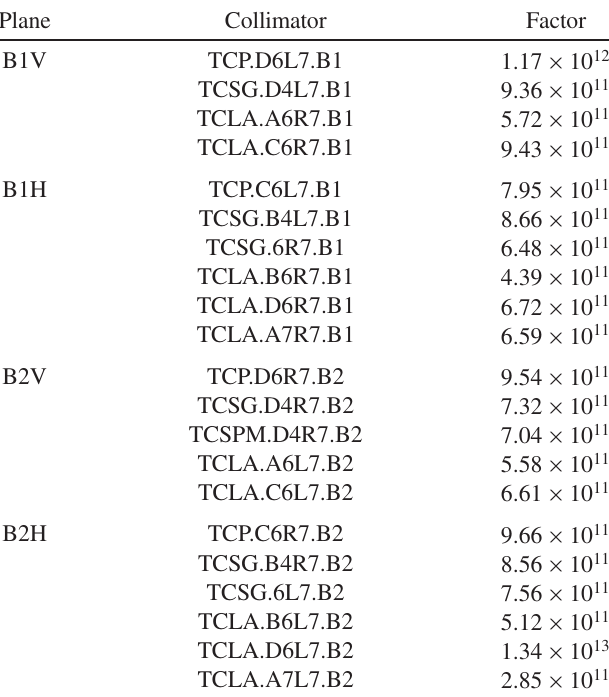
TABLE V. Cross-talk factors (protons per Gy), calculated from the change in beam intensity using the individual